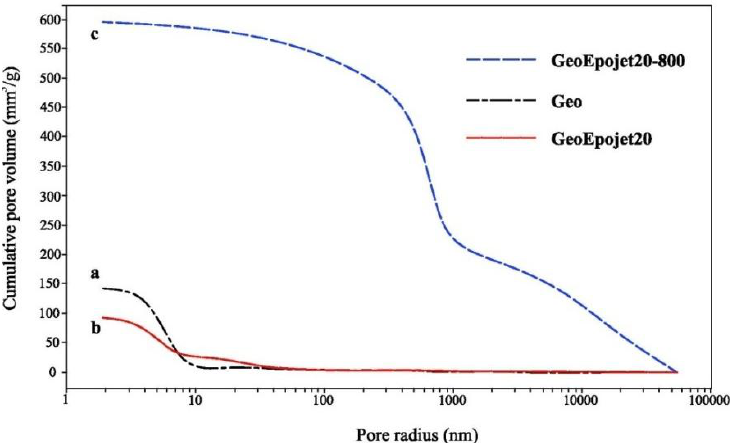
Figure 9. Cumulative pore volume vs. pore radius as obtained by mercury intrusion porosimetry